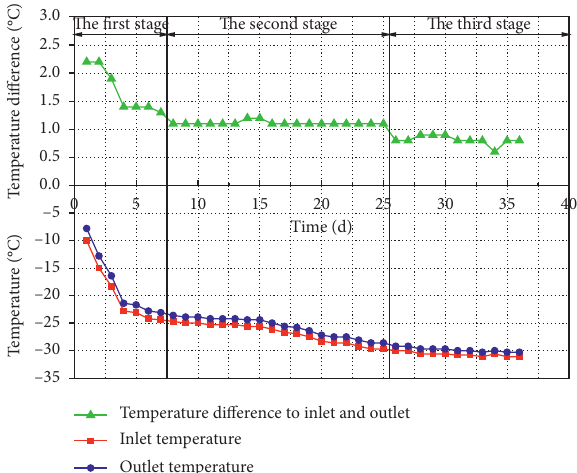
Figure 11: Temperature and temperature difference curves of the brine inlet and outlet.